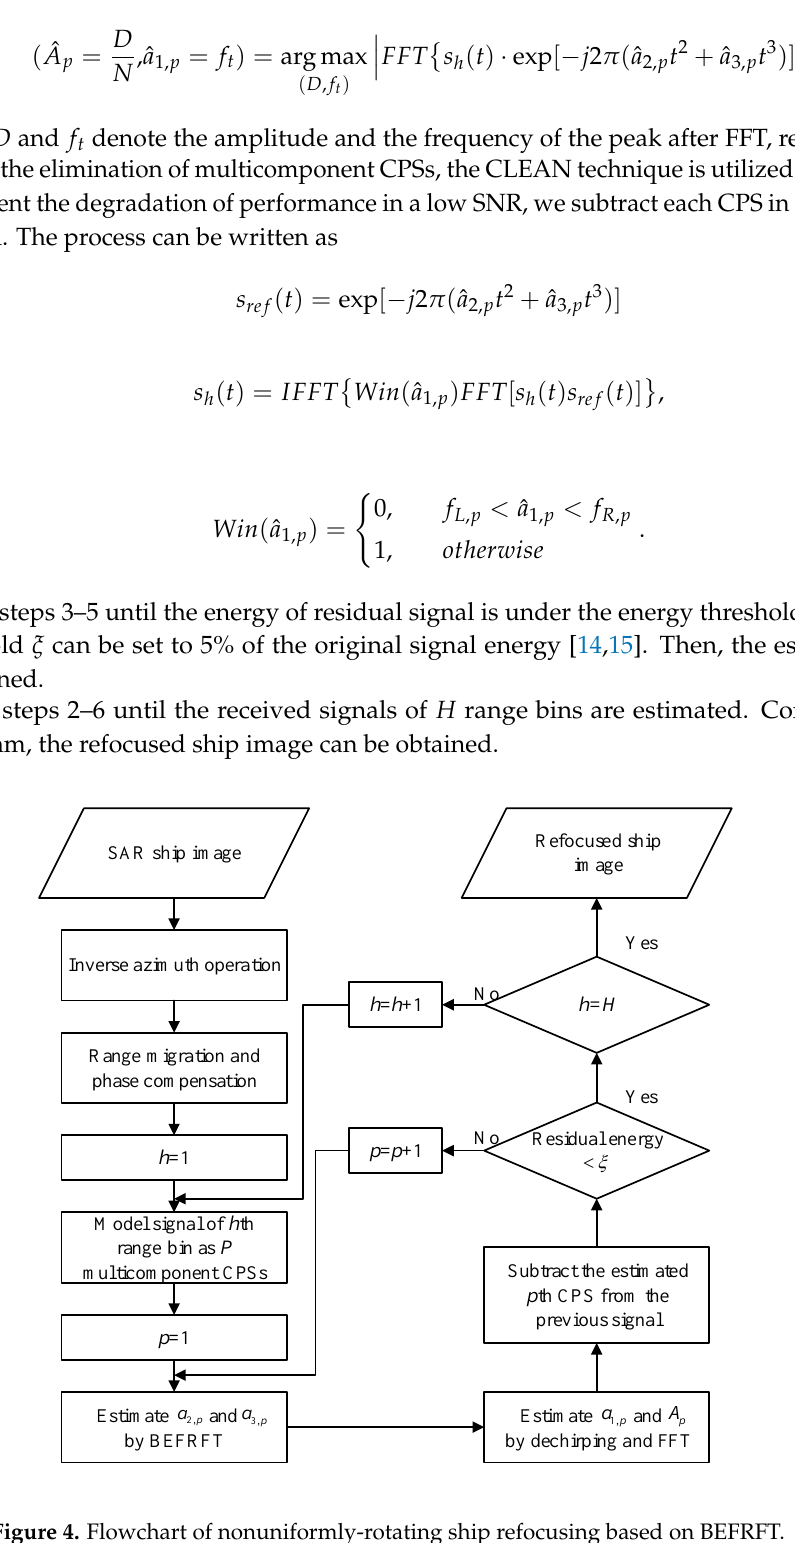
Figure 4. Flowchart of nonuniformly-rotating ship refocusing based on